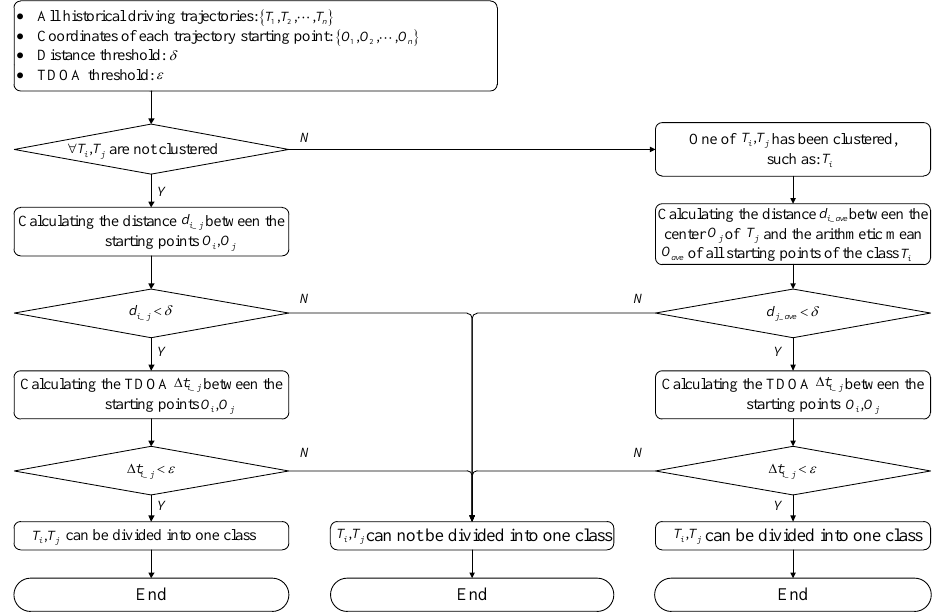
Figure 1. Clustering algorithm for starting point of travel trajectory.